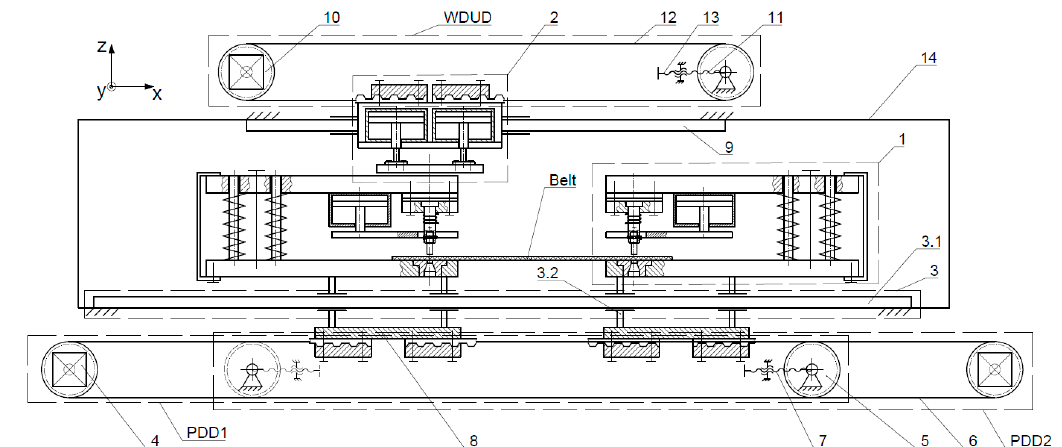
Figure 1. Schematic of the belt perforation device in a configuration using a punch and a die [23]: 1—punching die, 2—work drive unit (WDU), 3—punching die guide, 4—drive wheel assembly for punching die drive, 5—driven wheel assembly punching die drive (PDD), 6—lower toothed belt, 7—lower belt tensioner, 8—punching die drive mount, 9—WDU guide, 10—WDU drive wheel assembly, 11—WDU driven wheel assembly, 12—upper toothed belt, 13—upper belt tensioner, 14—frame, Belt—perforated belt, PDDi—i-th punching die drive system, WDUD—WDU drive system.